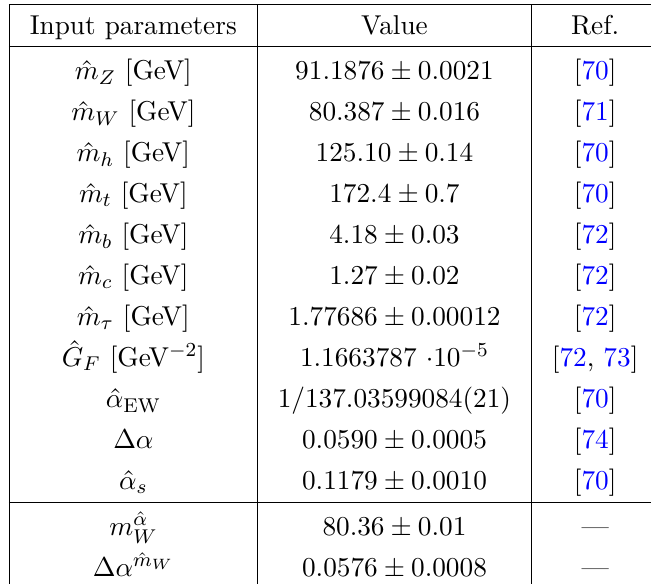
Table 1 . Input parameter values used from ref. [75]. m ˆ α { ˆ α, ˆ m Z , ˆ G F } scheme using the interpolation formula of refs. [74, 76–78], while ∆ α ˆ m W is the shift in the value of alpha due to hadronic effects for the { ˆ m W , ˆ m Z , ˆ G F } scheme. The remaining SM inputs are taken from the central values in the PDG